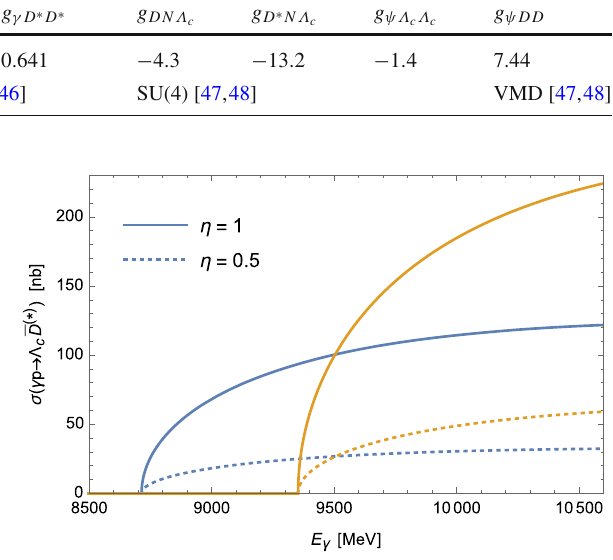
Fig. 5 Estimatesofthecrosssectionsforthe γ p → Λ c ¯ D (bluecurves) and γ p → Λ c ¯ D ∗ (orange curves)